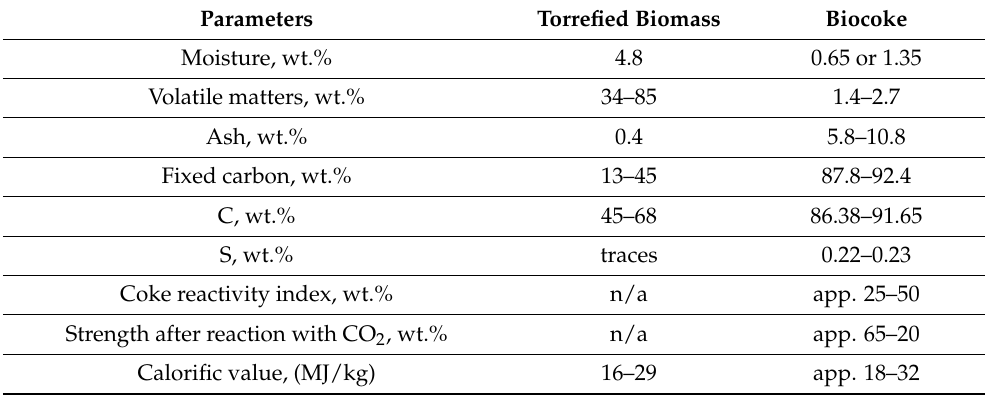
Table 2. Comparison of the properties of torrefied biomass and biocoke